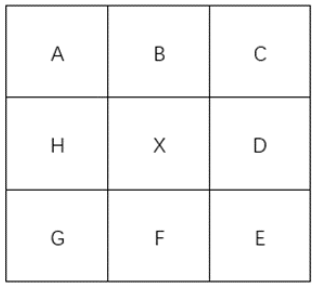
Figure 1. Curvature comparison matrix.